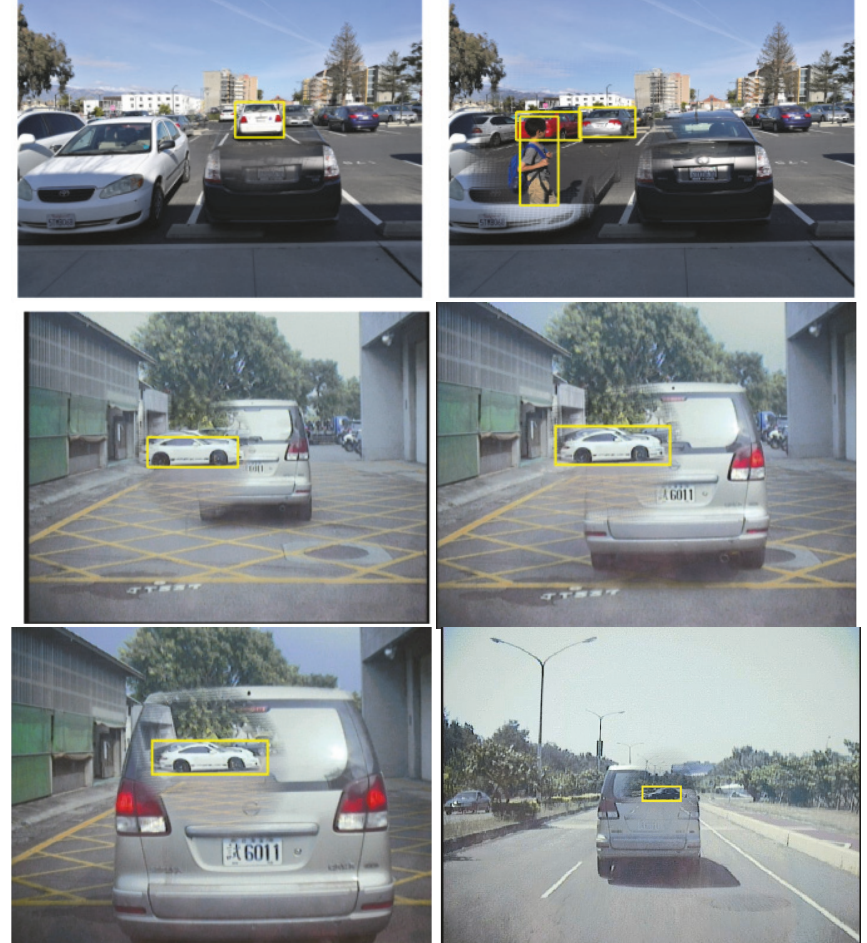
Figure 11: The object-based fusion